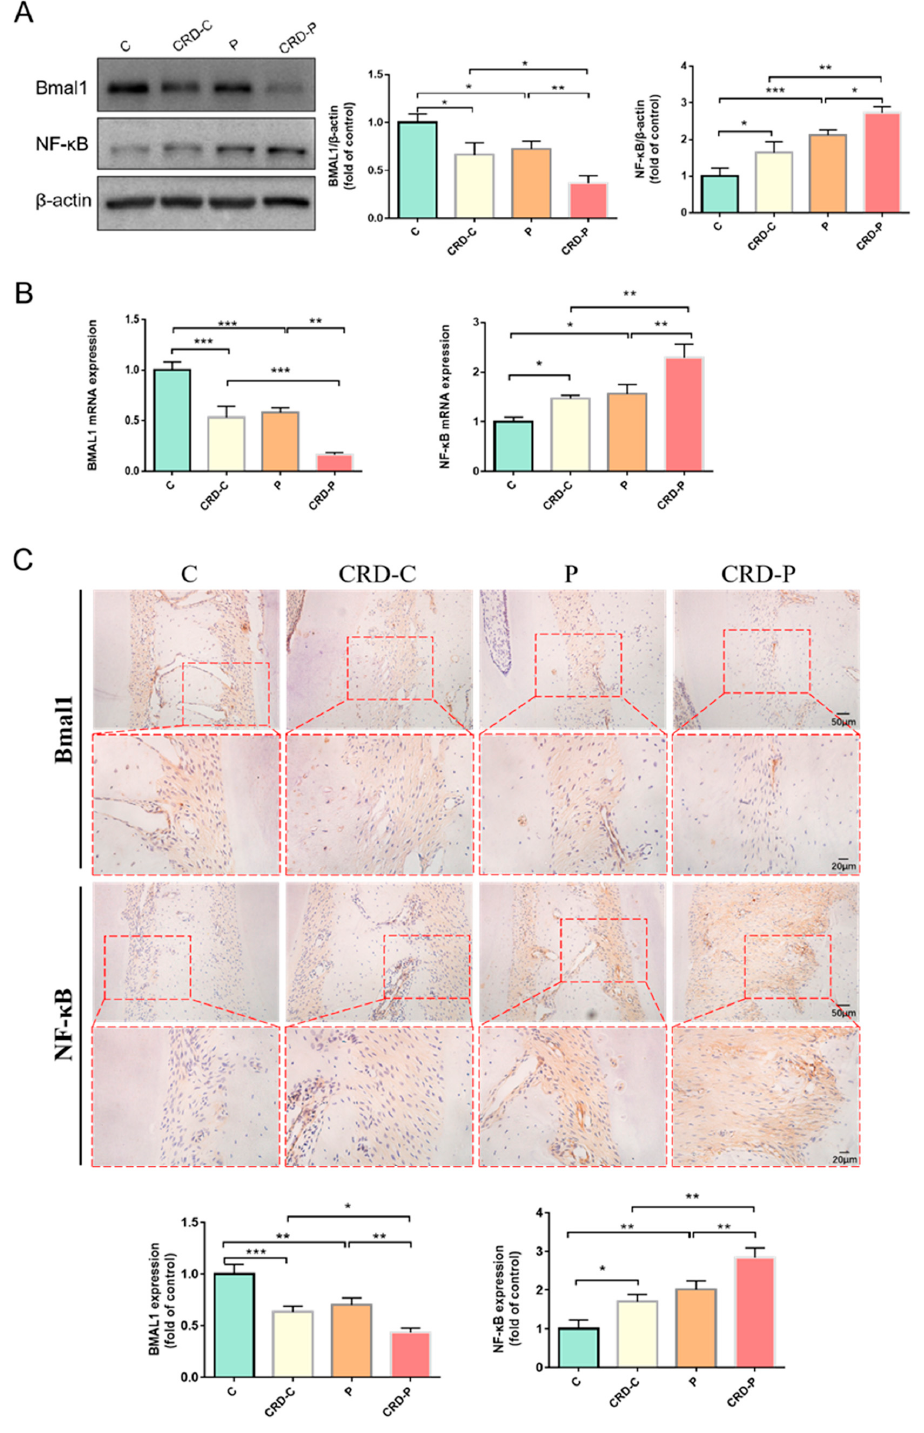
Figure 3. CRD promotes the progression of periodontitis by regulating BMAL1. ( A ) Western blot results and analysis of BMAL1 and NF- κ B. ( B ) BMAL1 and NF- κ B mRNA expression levels in gingival tissue of rat maxillary first molars. ( C ) Immunohistochemical staining of BMAL1, NF- κ B in the periodontal tissue of rat maxillary first molars (Scale bar = 20 µ m and Scale bar = 50 µ m). CRD: circadian rhythm disorders. C: control; CRD-C: CRD without periodontitis. P: periodontitis. CRD-P: CRD with periodontitis. Data are presented as the mean ± SD. * p < 0.05; ** p < 0.01; *** p <